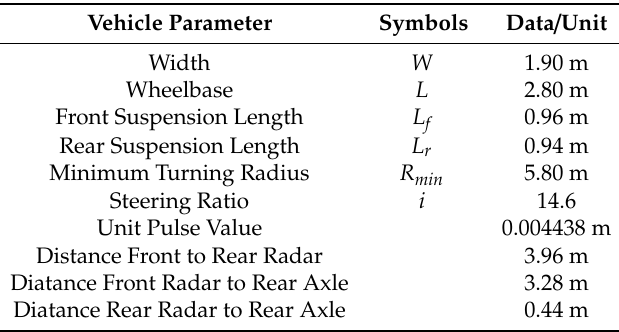
Figure 4. Parallel Parking Path Simulation with M Language. Table 1. Vehicle Parameters.